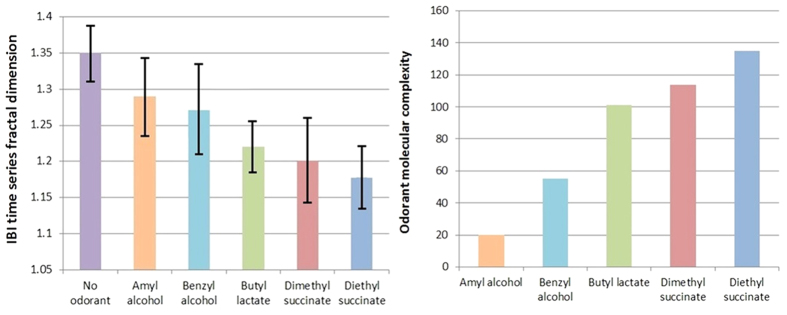
IBI time series fractal dimension in case of different odorants (on the left side), and the molecular complexity of odorants (on the right side).Error bars are standard deviations.